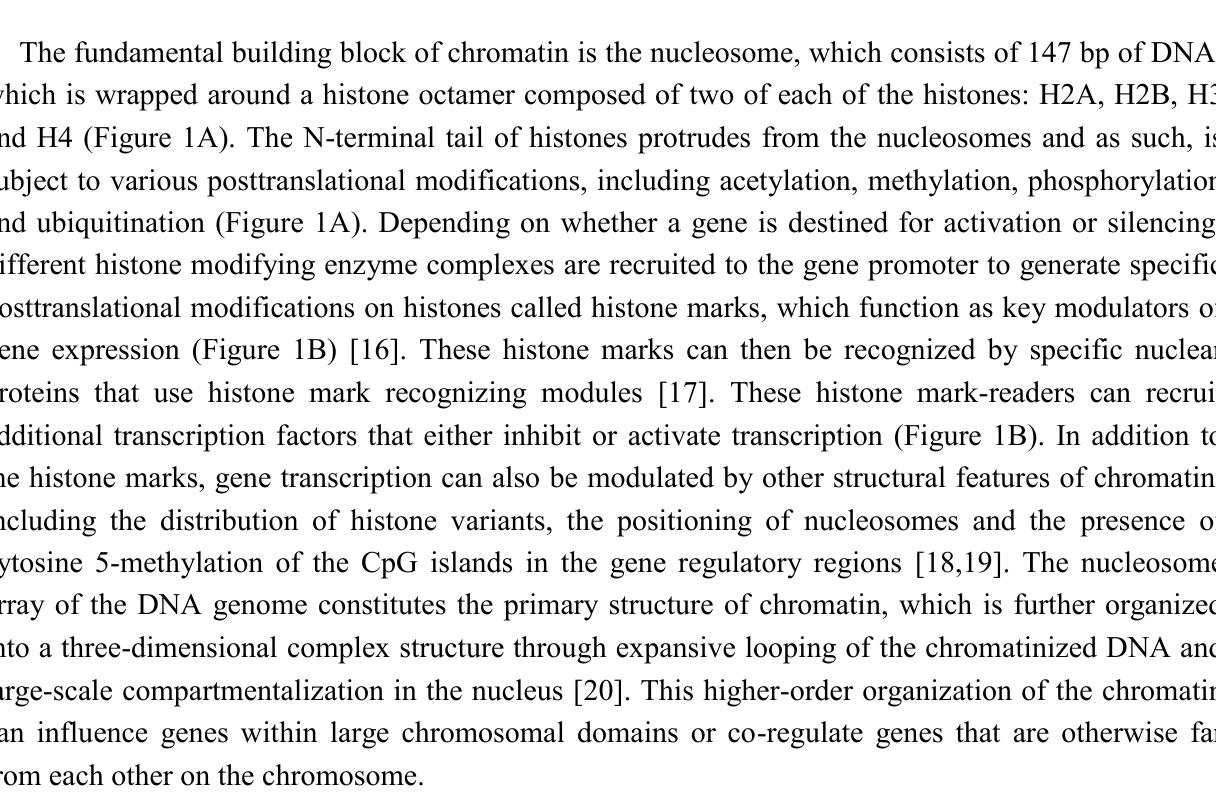
Figure 1. Chromatin components and their effect on gene expression. ( A ) The basic unit of chromatin is the nucleosome, which consists of 147 bp DNA wrapped around histones H2A, H2B, H3 and H4. The N terminus of histones is subject to different posttranslational modifications; ( B ) The levels and types of histone marks are dynamically regulated by antagonistic histone modifying enzymes (writers and erasers). Histone marks are recognized and interpreted by specific nuclear proteins (readers), resulting in the recruitment of either repressor or activator transcription regulatory complexes onto the target promoters. Some examples of repressive and activating chromatin modifications are listed in the boxed